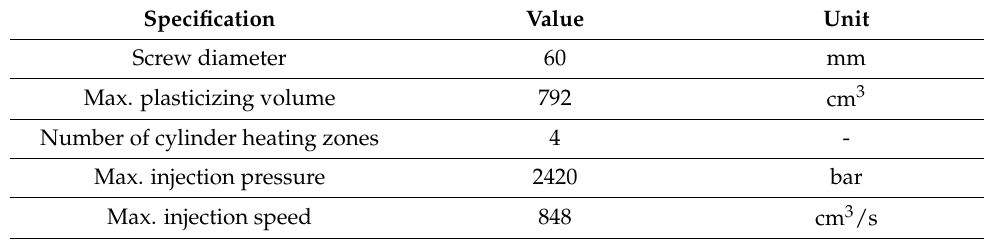
Table 1. Specifications of the KM 550/2000 GX injection molding machine.